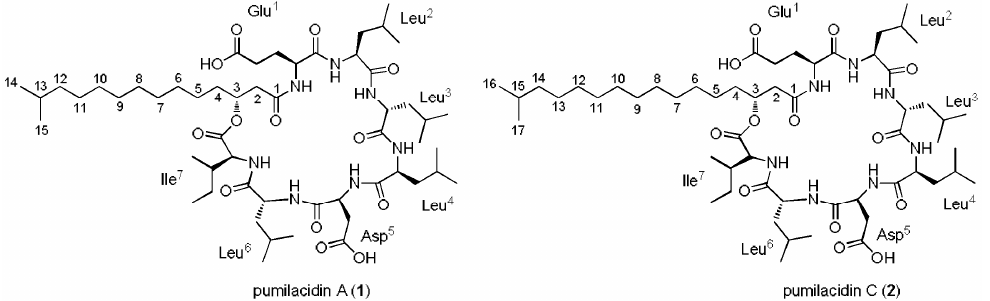
Figure 1. Structures of pumilacidins A and C .